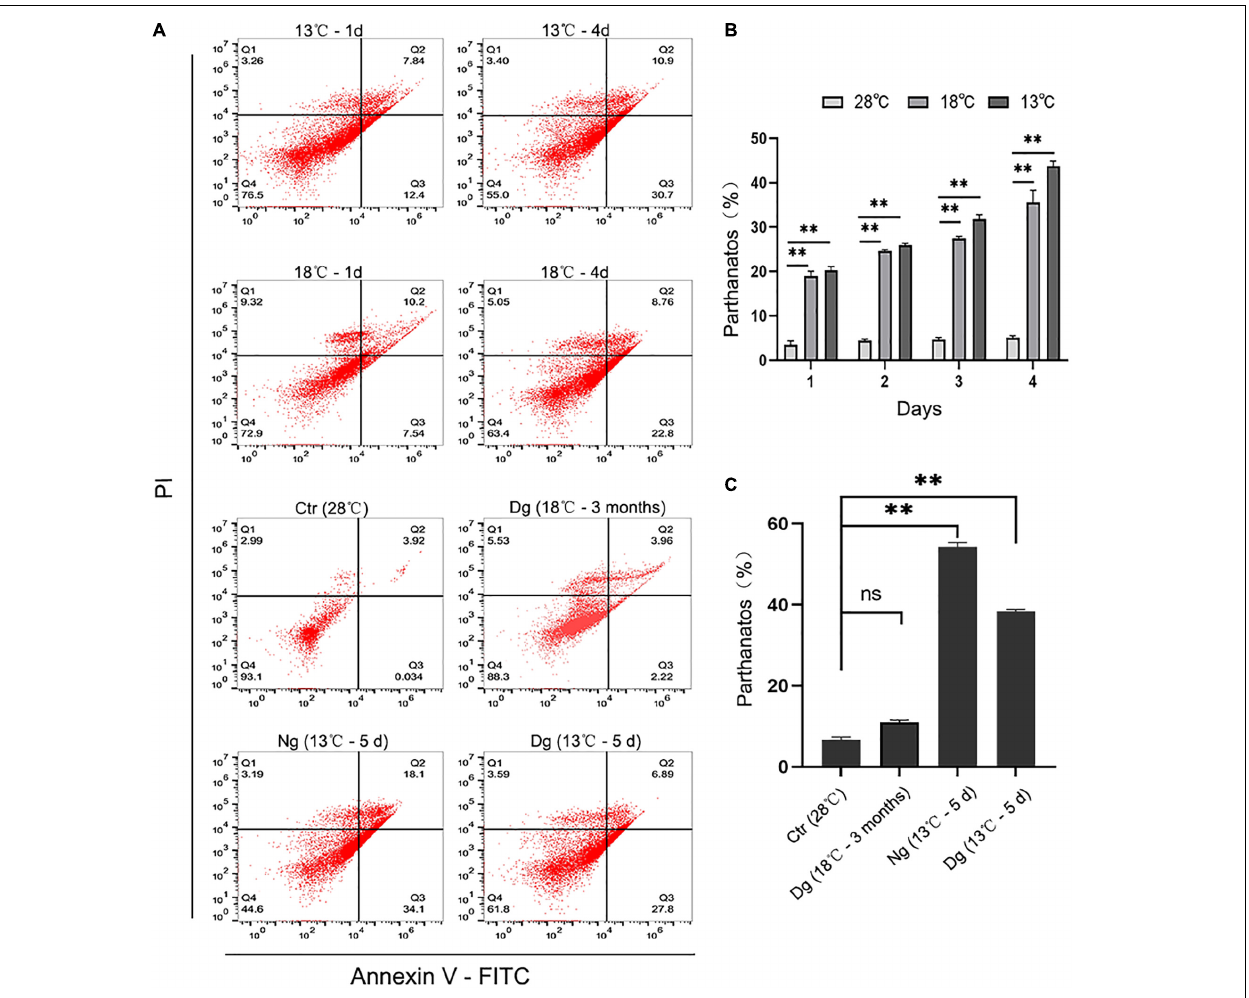
FIGURE 6 | Cold acclimation alleviated cold-induced cell apoptosis in ZF4 cells. Ctr, the control group; Dg, the domesticated group; Ng, the non-domesticated group. (A) Analysis of cell apoptosis by flow cytometry. Apoptosis was evaluated with AnnexinV-FITC/PI staining. (B,C) Apoptotic cells were calculated and graphed according to the flow cytometry results in GraphPad Prism 8 software. The results are presented as the mean ± SD ( n = 3); ∗∗ P <